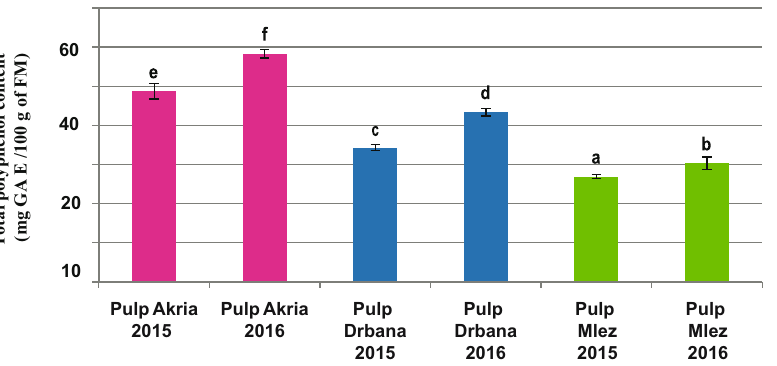
Figure 8: Phenolic content of the fruit pulp of the studied varieties ( Akria, Drbana, and Mlez ) produced in both 2015 and 2016 crop years. Average with the same letter did not present a signi fi cant di ff erence at p < 0.05.